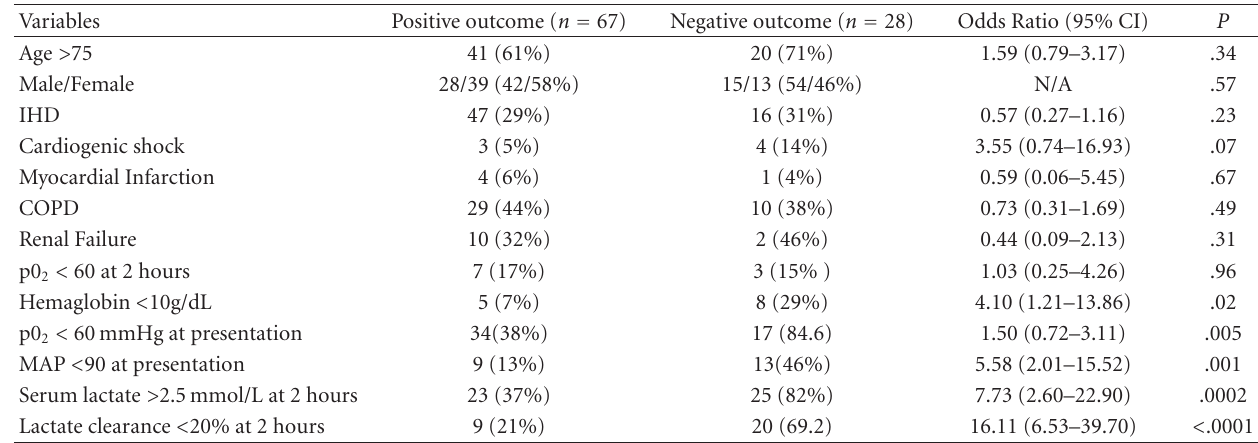
Table 2: Relationship between risk factors and negative